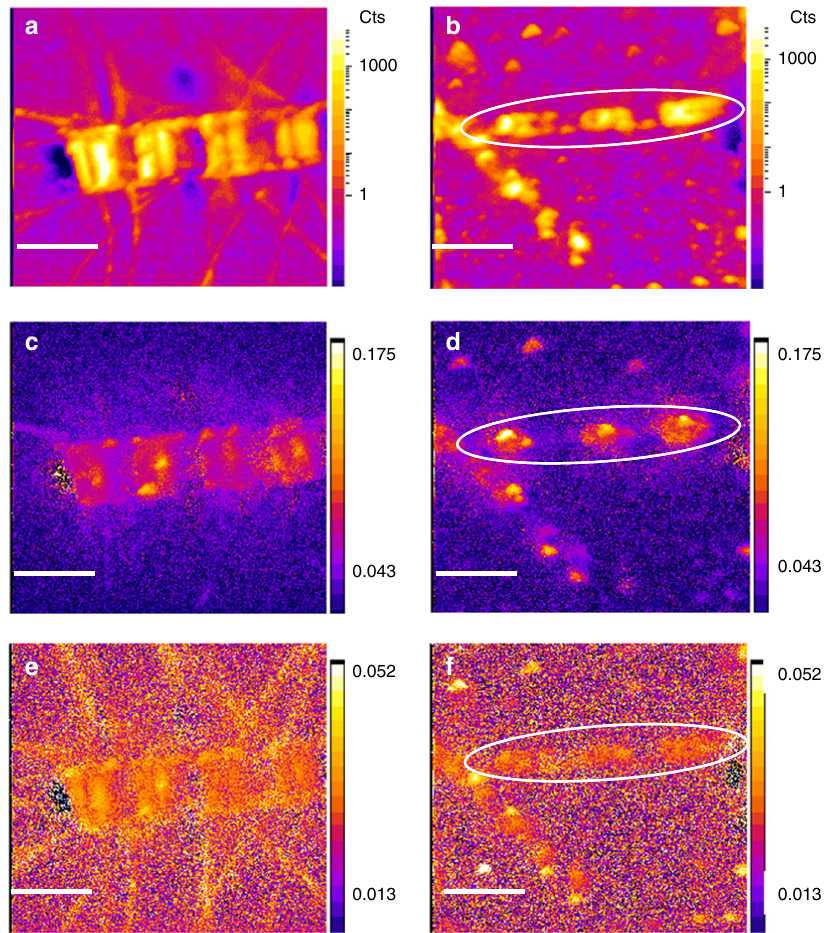
Fig. 2 SIMS images of Chaetoceros and Skeletonema cell chains. Chaetoceros ( a , c , e ) and Skeletonema ( b , d , f ) incubated with 13 C-HCO 3 − and 15 N-NO 3 − . The biomass distributions are demonstrated by the 12 C 14 N - images ( a , b ). The unit represent counts per pixel ( a , b ). SIMS images of 15 N: 14 N ratio ( c , d ) and 13 C: 12 C ratio ( e , f ) re fl ect nitrate assimilation and C assimilation, respectively. The scale bars represent 20 μ